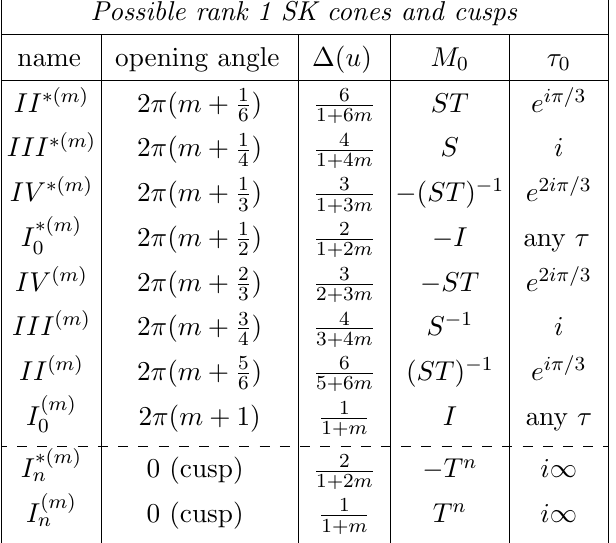
Table 1 . All geometries of 1-dimensional special K(cid:127)ahler cones and cusps. Shown are the allowed values of the opening angle 2 (cid:25)(cid:15) , of the mass dimension of the uniformizing parameter (cid:1)( u ), of the EM duality monodromy conjugacy class about the tip of the cone M 0 , and of the value of the complex modulus of the (cid:12)ber near the tip (cid:28) 0 . m (cid:21) 0 is a non-negative integer, and n > 0 is a positive integer. The (cid:12)rst eight rows are scale-invaraint conical geometries, while the last two rows are non-scale-invariant cusp-like